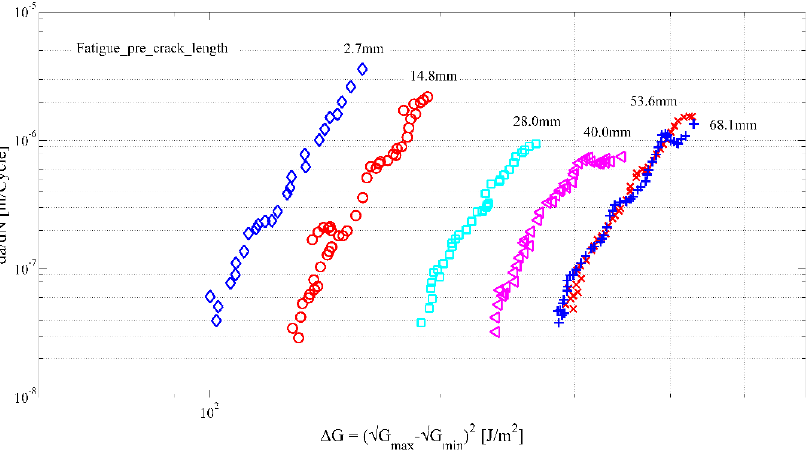
Figure 2. Paris curves for delamination propagation from six test sequences on a single DCB specimen illustrating the influence of pre-crack length and fibre bridging length [36].